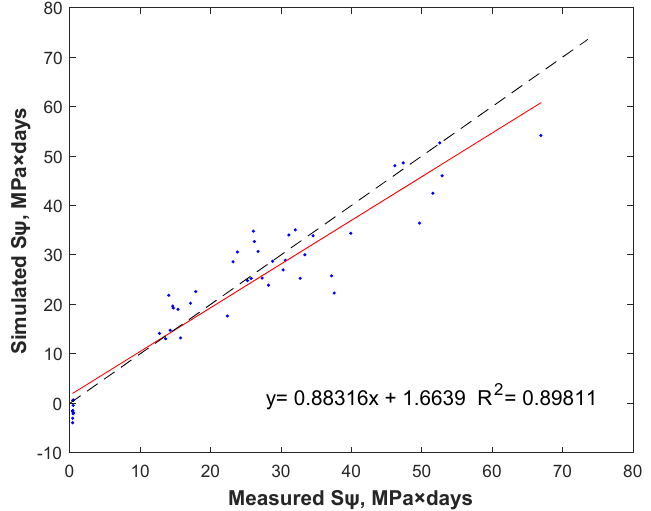
Figure 7. Correlation between the measured and predicted S ψ using the best predictive multispectral ANN model in the 2018 season.